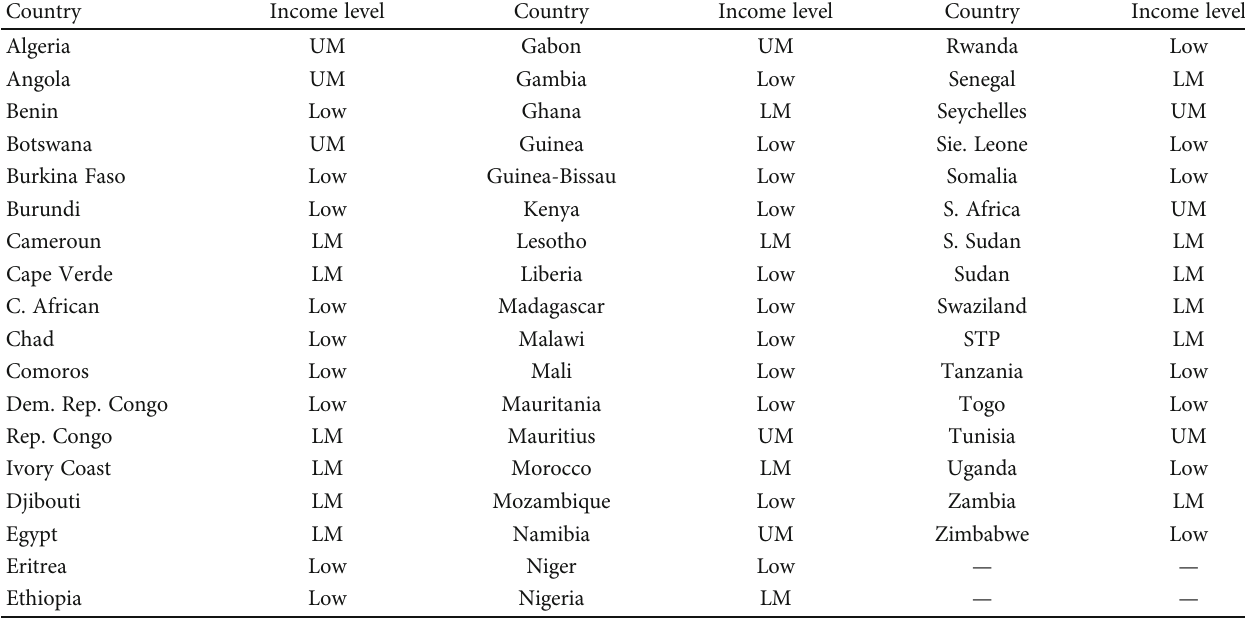
Table 1: Countries and income groups of sample Green PPP projects.